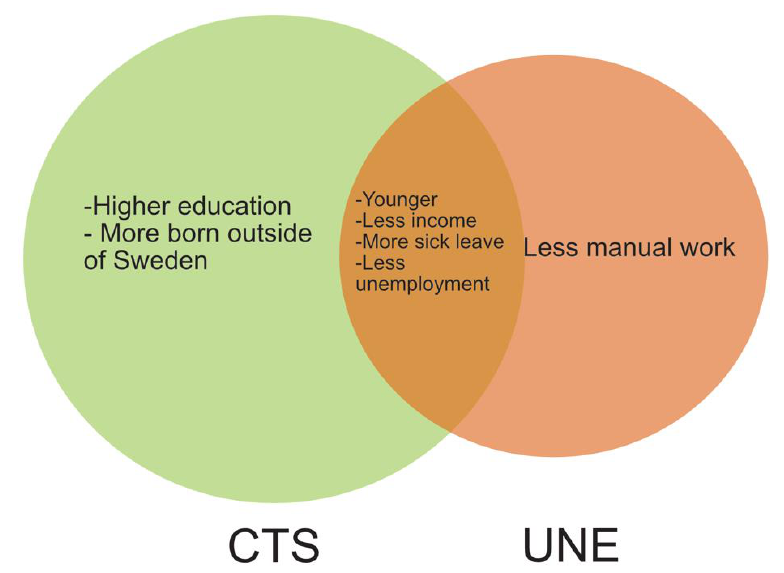
Figure 2. Schematic illustration (Venn diagram) showing characteristics of women surgically treated for carpal tunnel syndrome (CTS) or ulnar nerve entrapment at the elbow (UNE) in comparison to men (not shown)—differences and similarities in socioeconomic factors.